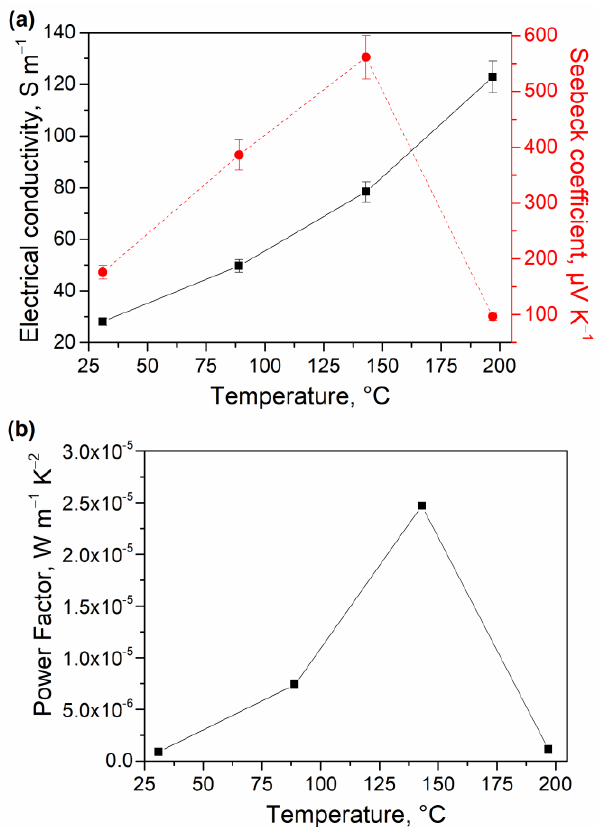
Figure 4. Temperature-dependent electrical conductivity and Seebeck coefficient ( a ), as well as Power Factor ( b ) of the p -type PbSe QD thin films.